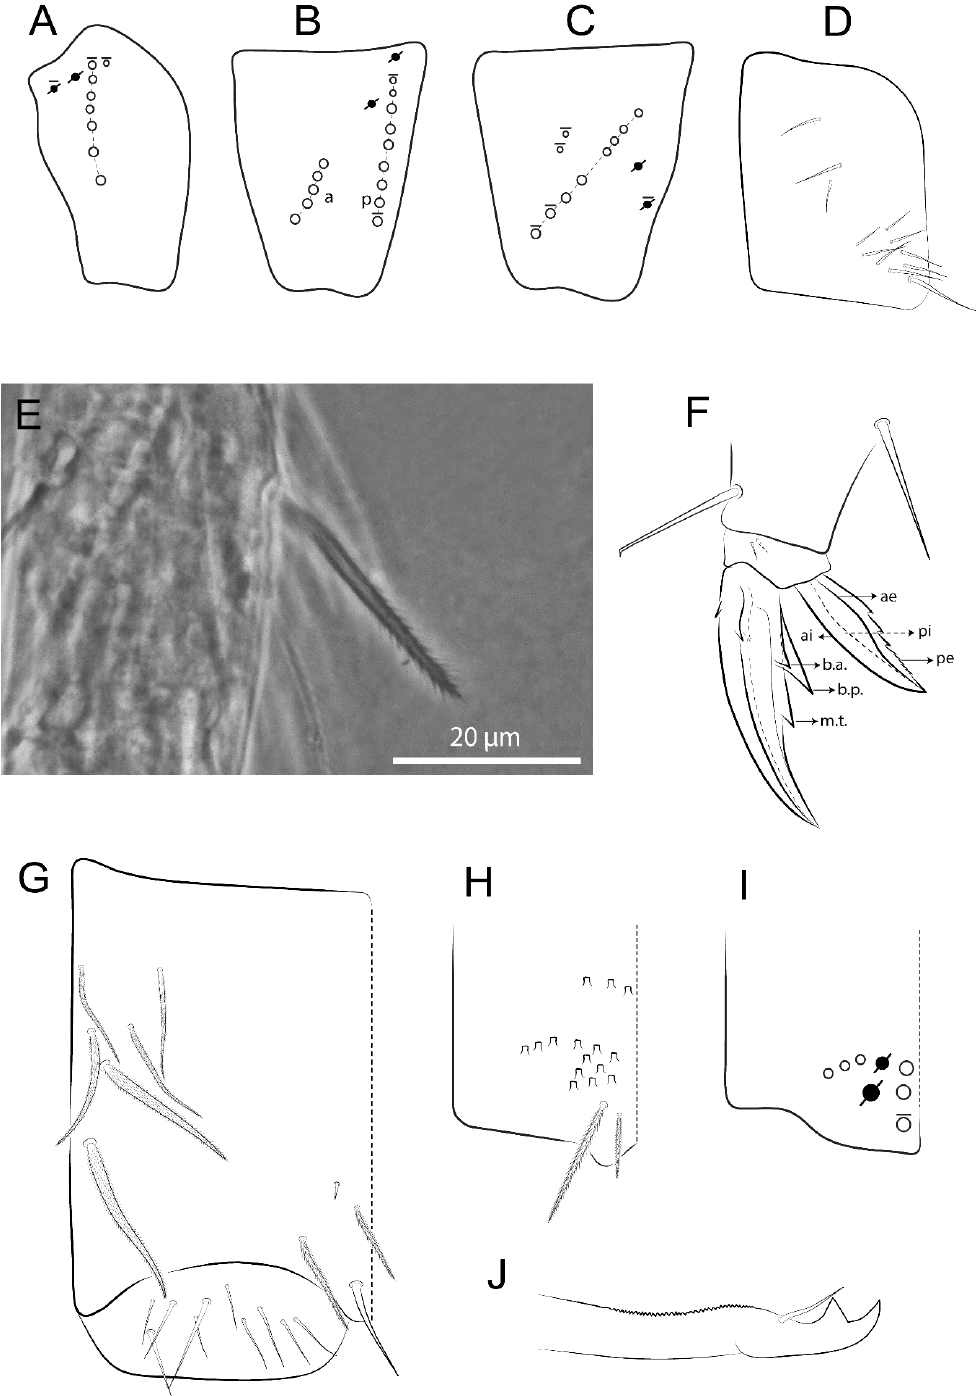
Figure 42. Pseudosinella aphelabiata sp. nov.: trunk appendages. ( A – C ) subcoxa I–III, respectively; ( D ) trochanteral organ; ( E ) modified chaeta of tibiotarsus III; ( F ) distal tibiotarsus and empodial complex III (anterior view); ( G ) collophore (lateral view); ( H ) distal part of manubrium (ventral view); ( I ) manubrial plate (dorsal view); ( J ) distal dens and mucro (inner view).